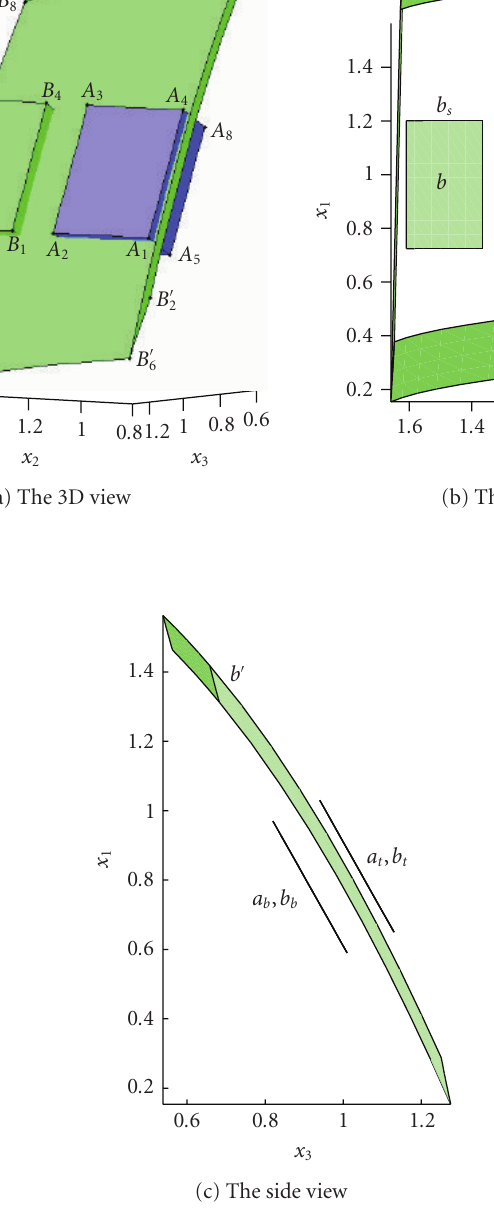
Figure 3.5. b (cid:9) 4 ( b ) wholly across a and